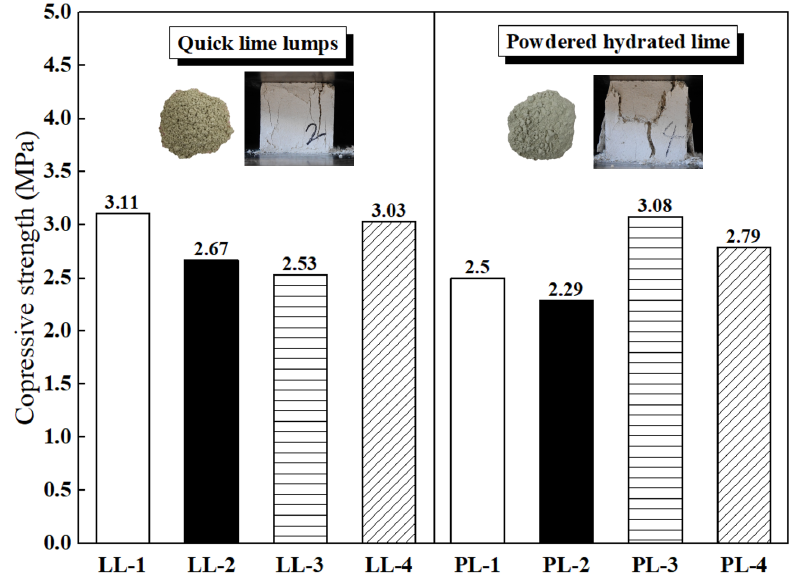
Figure 11. Compressive strength at 56